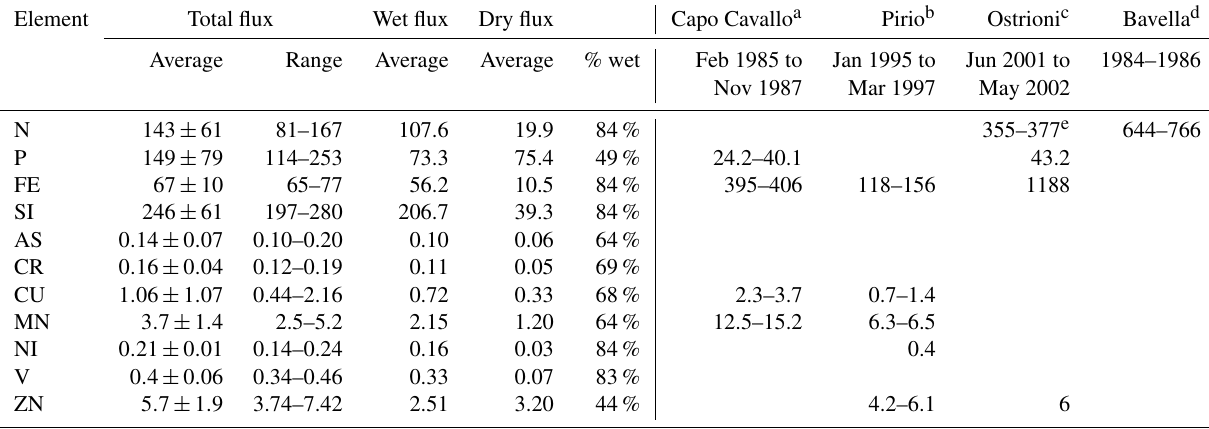
Table 1. The left part shows the annual total and wet and dry deposition fluxes (mgm − 2 yr − 1 ) of major nutrients and trace elements and the relative contribution (%) of wet periods to the total fluxes measured at Capo Cuittone, Corsica, between March 2008 and October 2011. The right part shows annual deposition fluxes at various sites in Corsica available in the literature.